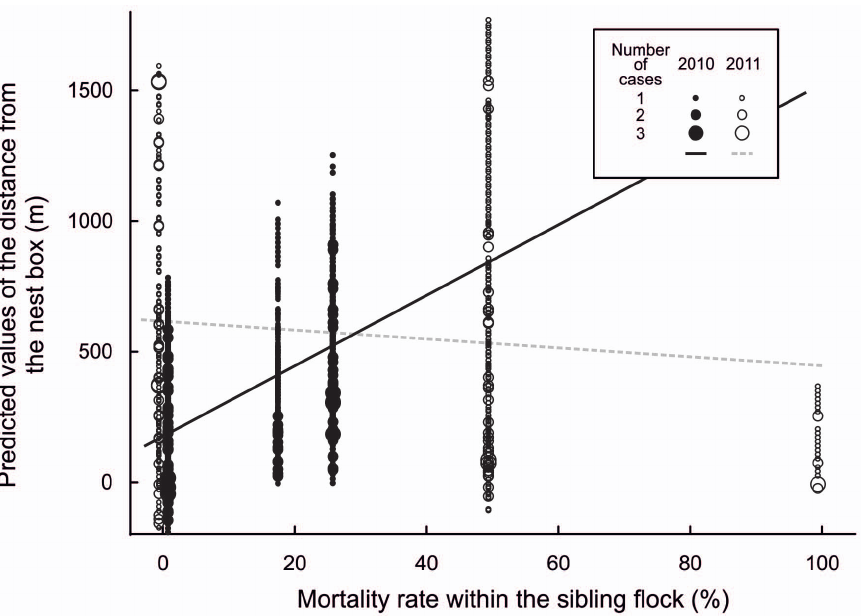
Figure 4. Predicted values of the distance from the nest box for 2010 (filled circles) and 2011 (open circles) plotted against the mortality rate (%, the number of dead fledglings as percentage of the total number of fledglings) within the sibling flock.